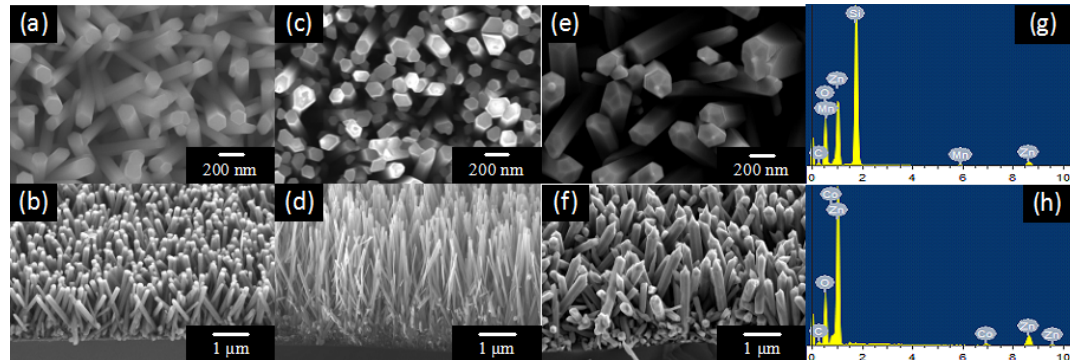
Figure 2. Scanning electron microscopy (SEM) images of the top and side view of ( a , b ) ZnO; ( c , d ) Mn-doped ZnO; ( d , e ) Co-doped ZnO. Energy dispersive X-ray spectroscopy (EDS) pattern of ( g ) Mn-doped ZnO; ( h ) Co-doped ZnO. Table 1. The atomic percentage of elements in Mn-doped and Co-doped ZnO nanowires. Atomic Percentage (%) Element Mn-Doped ZnO Co-Doped ZnO C 9.31 13.50 Zn 43.23 40.97 O 44.73 44.84 2.72 / Co /